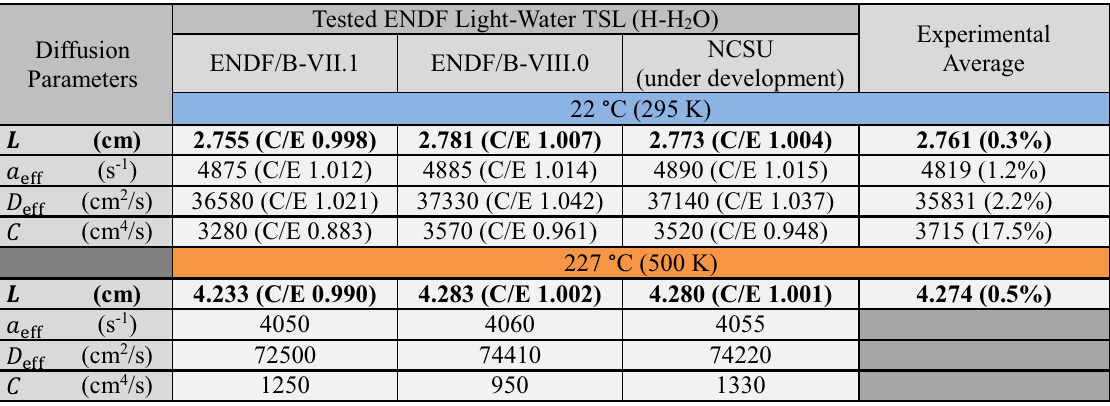
Table II. Diffusion Parameter Results Compared to Experimental Averages.